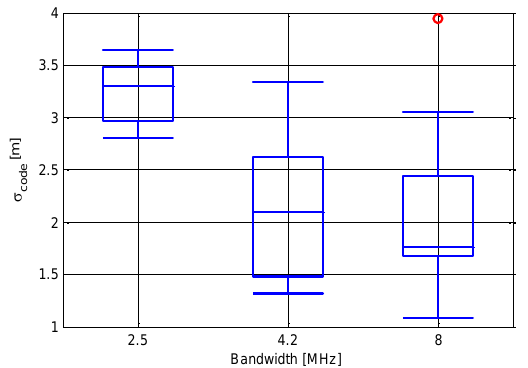
Figure 7. Distribution of code tracking errors for different bandwidths (for GPS L1 C/A